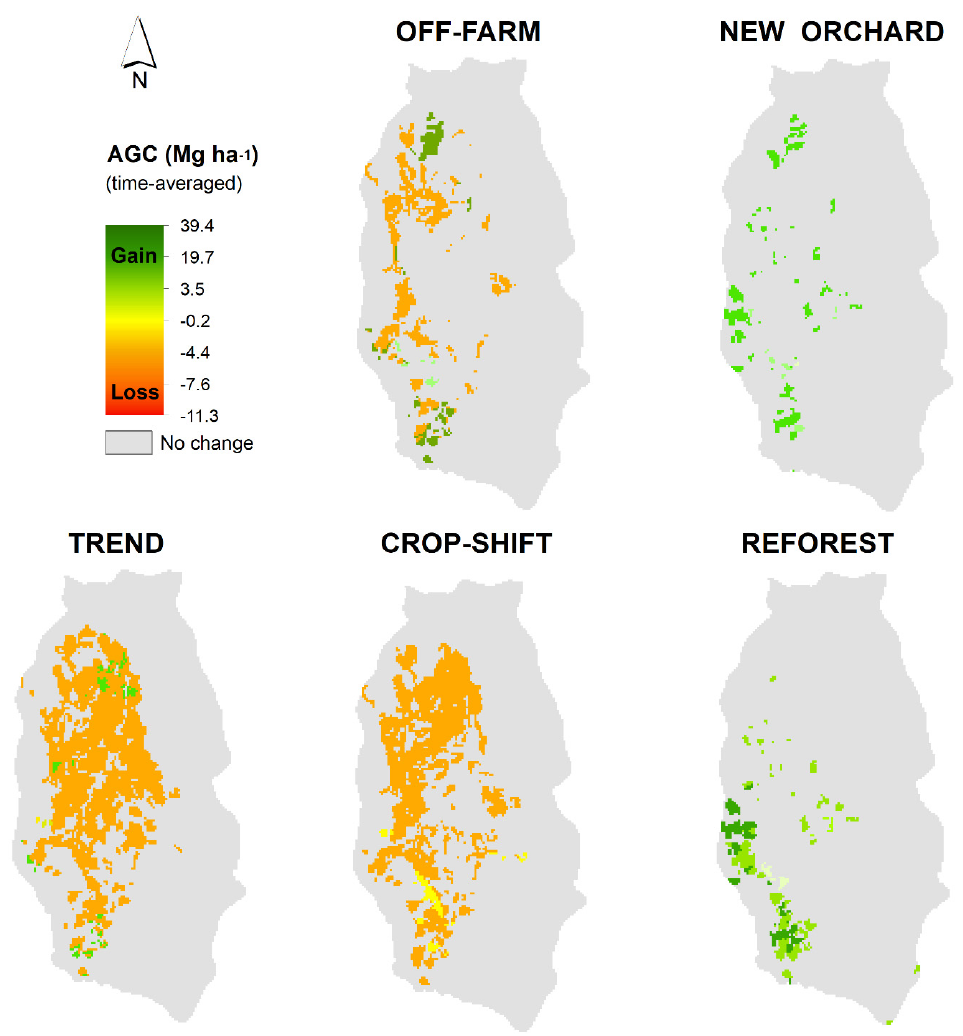
Figure 7. Prospected scenario-specific time-averaged above-ground carbon (AGC) gains and losses (in Mg ha − 1 ) in 2029 simulated with the coupled Dyna-CLUE carbon accounting model procedure.